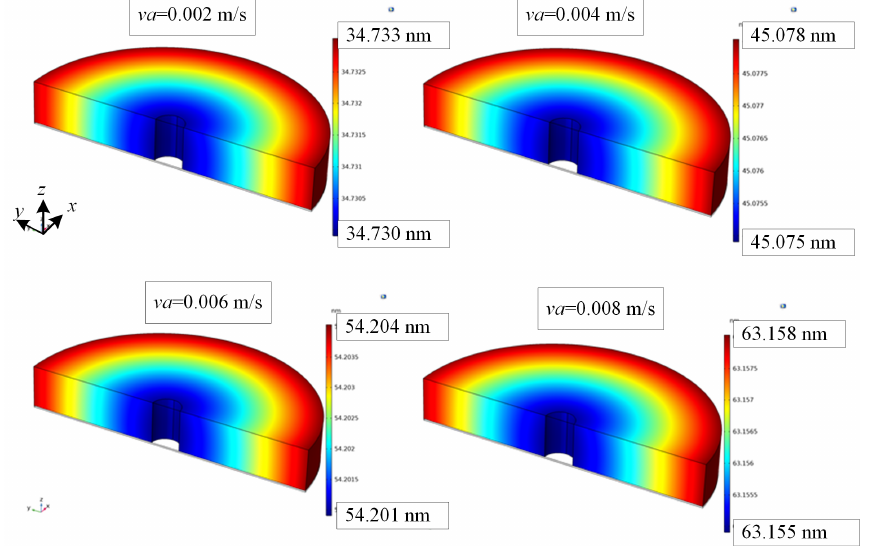
Figure 4. Time-average amplitudes A a of vibration from FEM FSI model in total time 0.005 s under different inlet air velocities v a